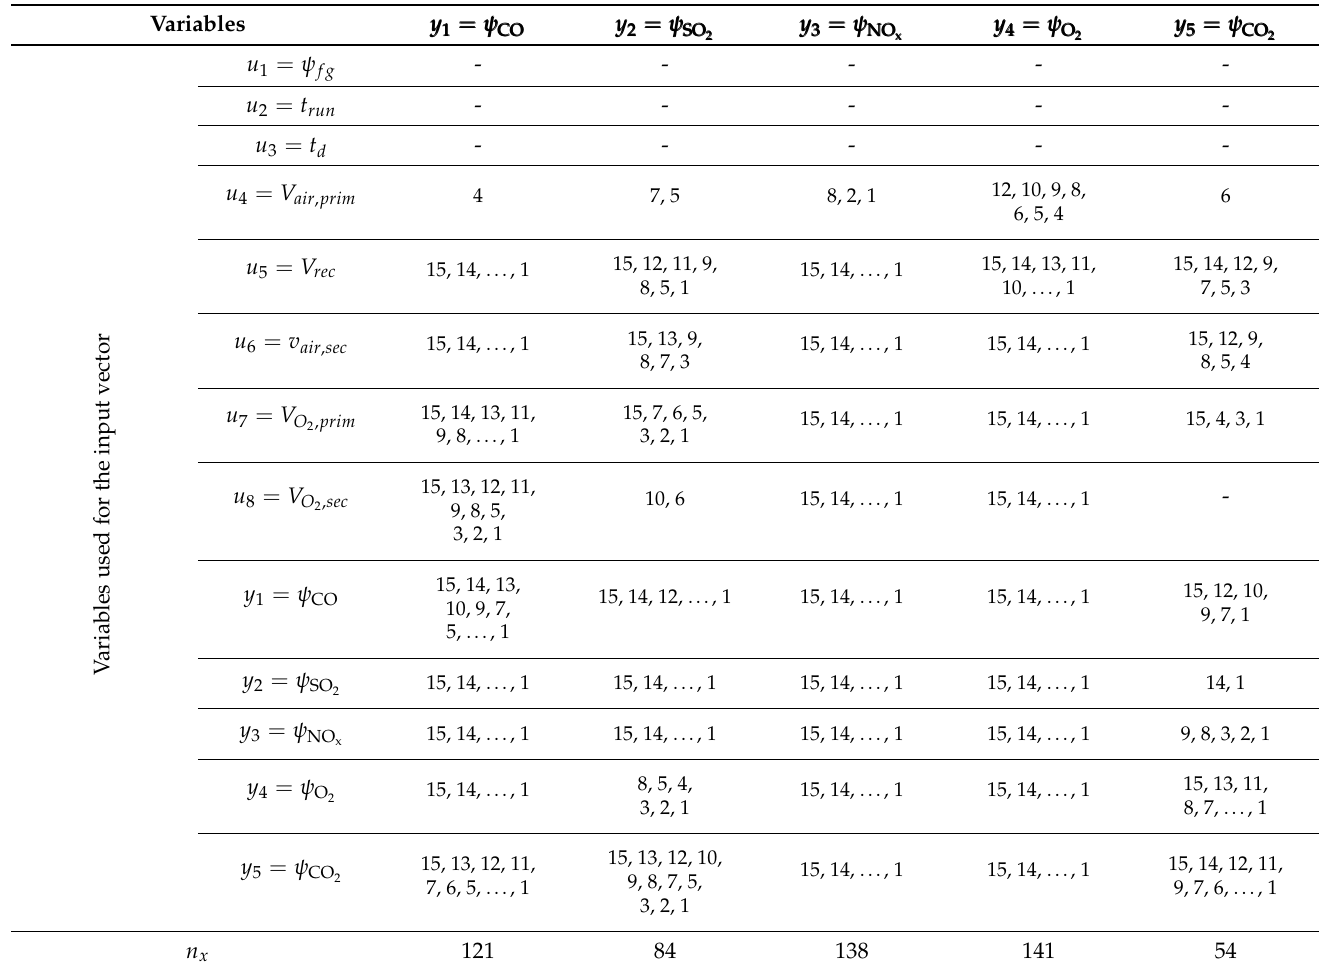
Table 3. Table of state vectors x i for outputs y i (listed in columns) proposed by Boruta Feature Selection Algorithm for sampling period ∆ T s = 5 s. Features u 1 , u 2 , u 3 were not picked by BFSA at all, u 8 is not chosen for y 5 .